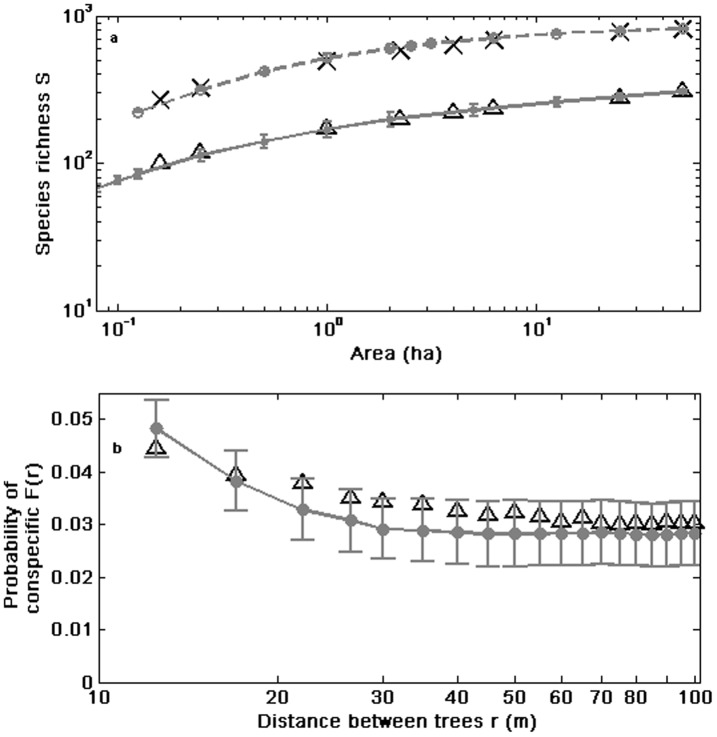
Species-area curves (SAR) and spatial patterns of tree species richness for selected censuses of tropical forests.Predicted curves correspond to averages over 100 simulations for the best estimates of model parameters (Fig. 2a), and the error bars correspond to one std. a. Observed and predicted (grey line) number of tree species with dbh≥1 cm for sampling areas of different sizes at Barro Colorado (1990, triangles) and Pasoh (1987, crosses). Estimated curves for Barro Colorado and Pasoh were calculated using data from the Center for Tropical Forest Science [11] and dividing the entire plots into non-overlapping quadrats [29]. The calculation of the SAR is explained in Information S1. b. The estimated (triangles) and predicted probability F(r) that two randomly selected trees of dbh≥10 cm located r meters apart for the 1990 census at Barro Colorado plot are conspecific. The curves are shown only for 10≤r≤100 m, a range of distances for which the NTB fails to reproduce the estimated F(r) [6].